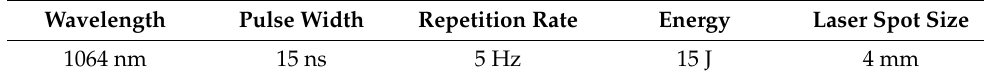
Table 2. LSP parameters.